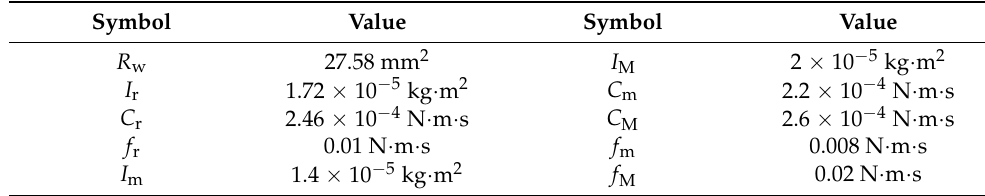
Table 1. Parameters of GTUSM-60-R.